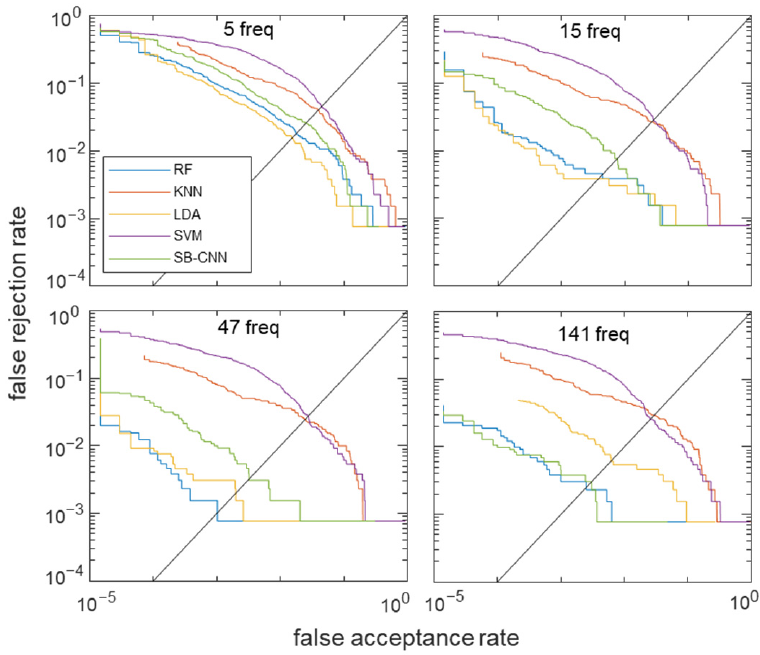
Figure 9. ROC of the acoustic spectra for five classifiers of RF, kNN, LDA, SVM, and SB-CNN for each number of frequencies.